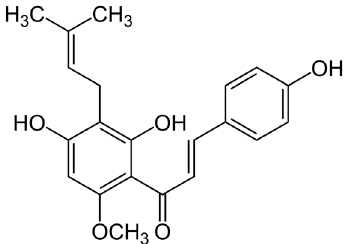
Figure 2. Chemical structure of xanthohumol.